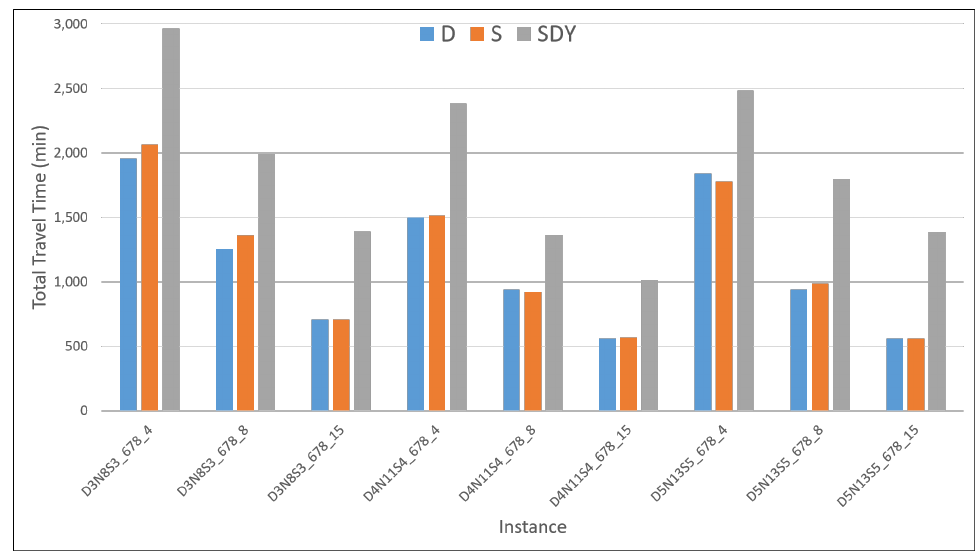
Figure A7. Total Travel Time for Maximum Road Capacity Setting ( 6,7,8 ) : Offline and Online Computation for all Instances based on Model Characteristic.